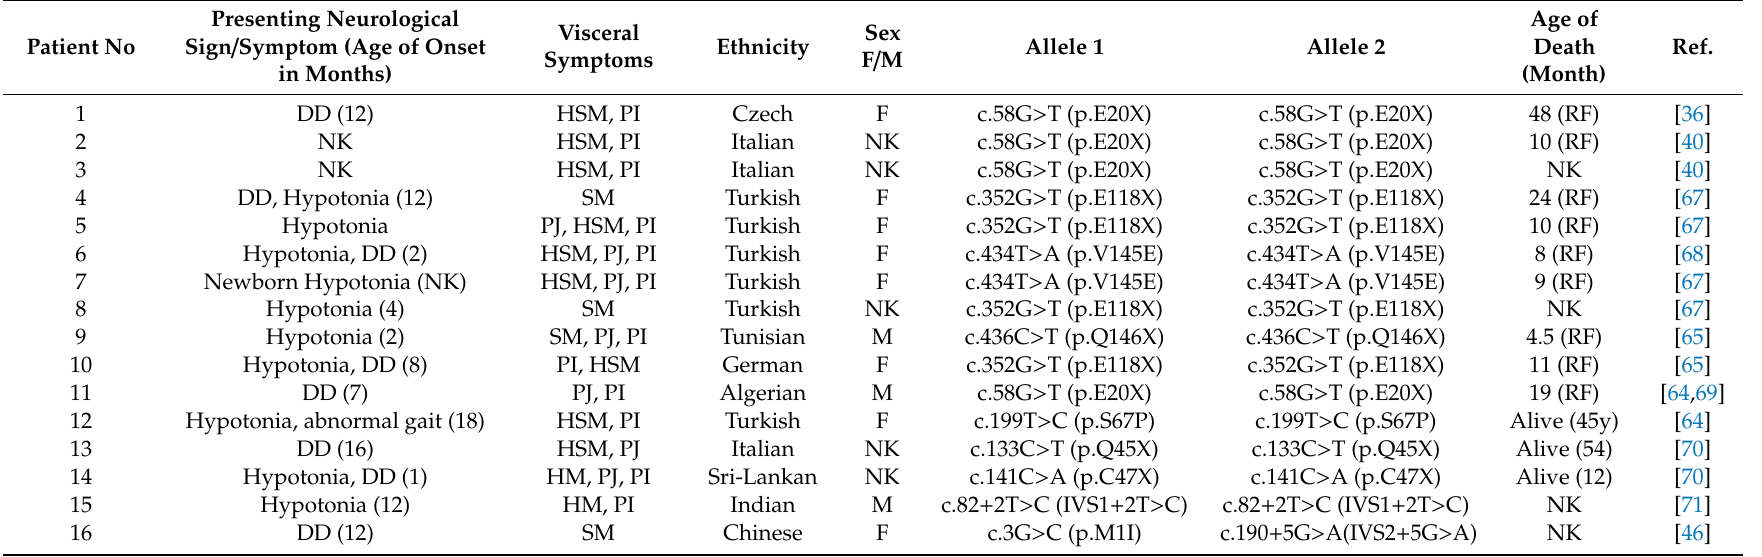
Table 5. Demographic, clinical, and molecular features of early infantile disease with NPC2